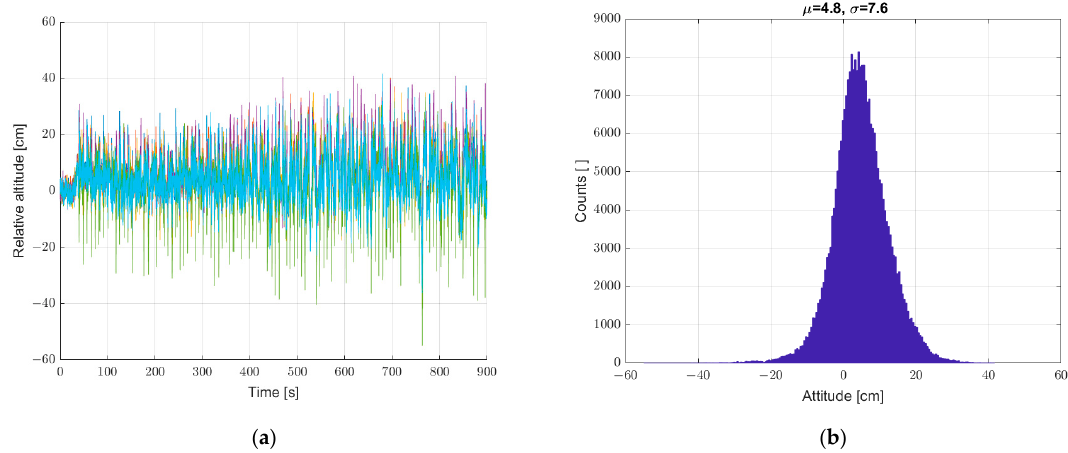
in Figures 13–15.